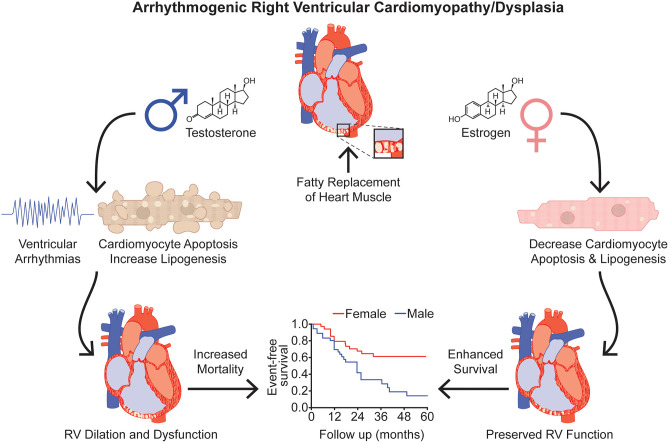
Effects of Sex Hormones in Arrhythmogenic Right Ventricular Cardiomyopathy/Dysplasia. Testosterone is associated with increased risk of severe ventricular arrhythmias, cardiomyocyte apoptosis, and lipid accumulation in ARVC/D. Conversely, estrogen decreases cardiomyoyte apoptosis and cardiomyocyte lipogenesis. Testosterone and estrogen's divergent effects on apoptosis and lipotoxicity provide a potential molecular understanding for the clinical observation that female ARVC/D patients have improved RV function and survival compared to males. Event-free survival curve adapted from Lin et al. (2017). RV, right ventricle/ventricular.